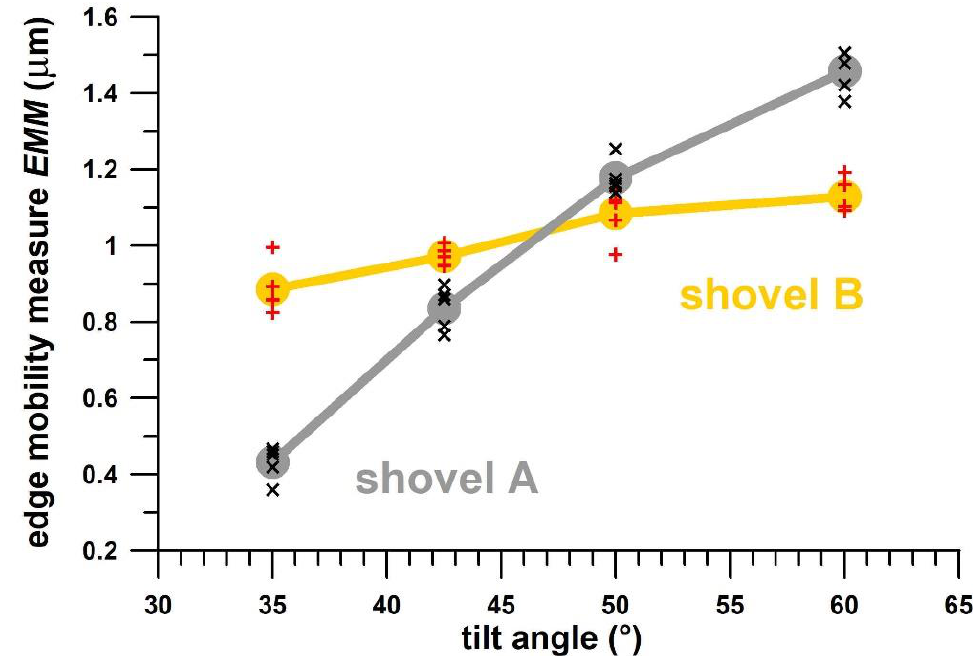
Figure 9. Edge Mobility Measure EMM of shovels A & B against the tilt angle; + , × : data of the five tests per board and tilt angle.